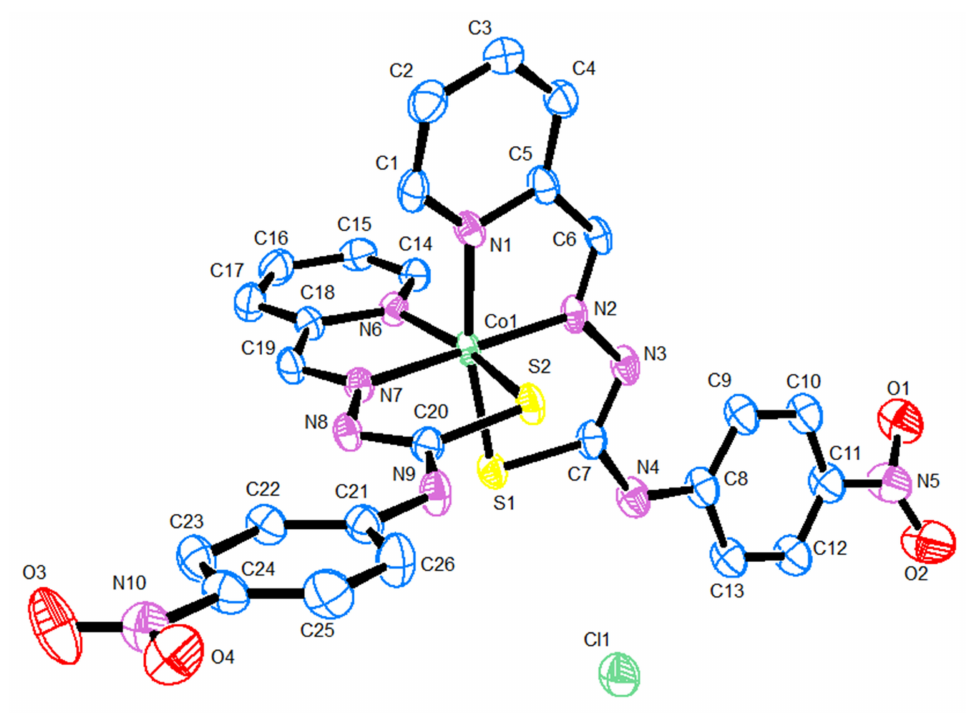
Figure 7. Molecular drawing of [Co(L 1 ) 2 ]Cl.2H 2 O ( C1 ) with thermal ellipsoids at 50% probability level (the crystallization water molecules and all H atoms have been removed for more clarity). Table 2. Selected bond lengths (Å) and angles ( ◦ ) for complex C1 . Atoms Distance (Å) Atoms Angle ( ◦ ) Atoms Angle ( ◦